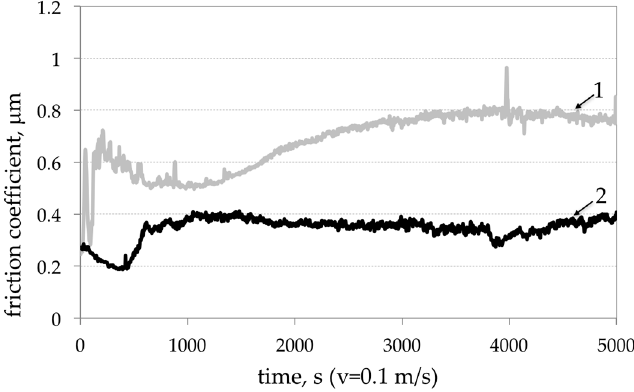
Figure 15. Comparison of friction coefficient changes in time: 1—AlSi7Mg2Sr003 base alloy; 2—AlSi7Mg2Sr0.03/SiC p 10 vol % composite.